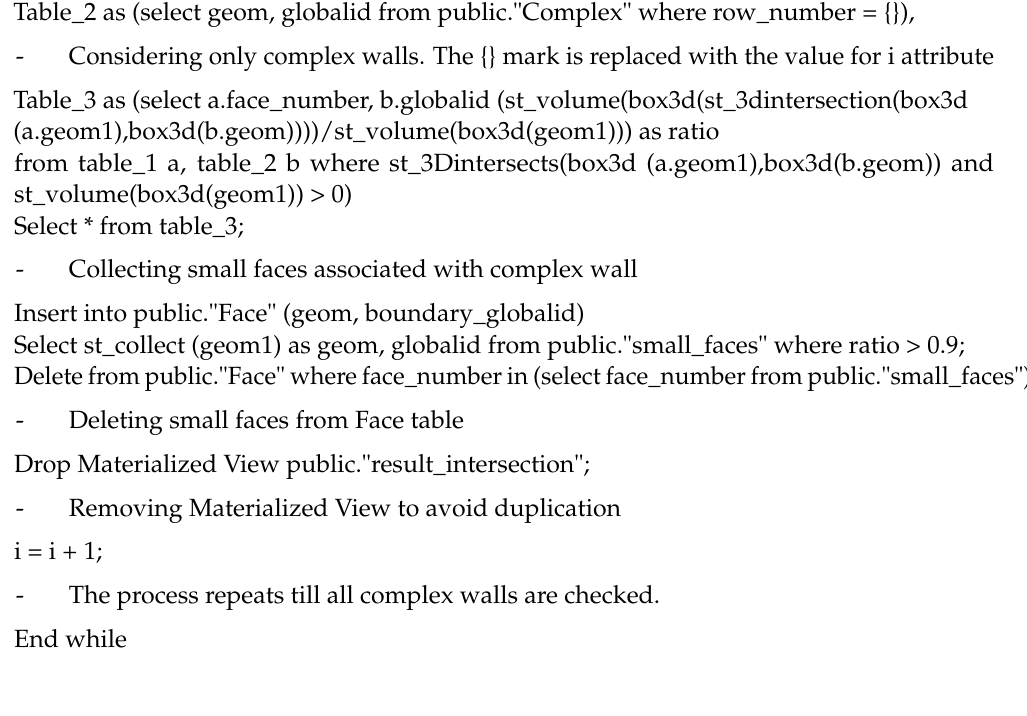
Table_6 as (select distinct b.geom, b.globalid, b.thickness, b.complex from table_1 a,